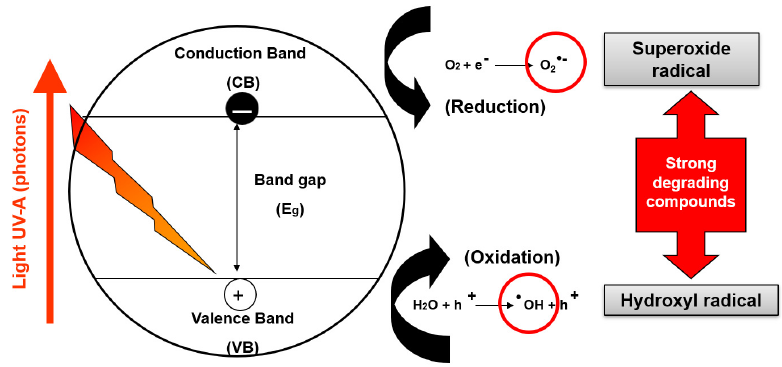
Figure 2. Illustration of the major processes occurring on a semiconductor TiO 2 particle following electronic excitation with UV-A (photons). Electron (e − )–hole (h + ) recombination can occur at the surface or in the bulk of the semiconductor. In addition, at the surface of the TiO 2 particle, photogenerated electrons can reduce an electron acceptor A (e.g., O 2 ) and a photogenerated hole can oxidize an electron donor D (e.g., H 2 O). Adapted with permission from Ref. [21]. Copyright 1995, American Chemical